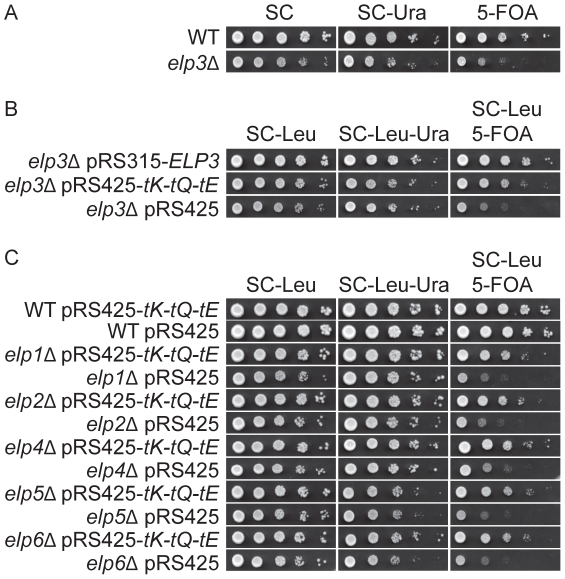
Increased levels of tRNALys
s2
UUU, tRNAGln
s2
UUG, and tRNAGlu
s2
UUC suppress the telomeric silencing defect of Elongator mutants.(A) The wild type (UMY2584) and elp3Δ (UMY3790) strains were 10-fold diluted, spotted on SC, SC-Ura and SC+5-FOA plates, and incubated at 30°C for 2 days. (B) The elp3Δ strain (UMY3790) with plasmids, pRS315-ELP3, pRS425-tK-tQ-tE or pRS425, were 10-fold diluted, spotted on SC-Leu, SC-Leu-Ura and SC-Leu+5-FOA plates, and incubated at 30°C for 2 days. (C) The wild type (UMY2584), elp1Δ (UMY3788), elp2Δ (UMY3789), elp4Δ (UMY3791), elp5Δ (UMY3792) and elp6Δ (UMY3793) with plasmids pRS425-tK-tQ-tE or pRS425 were treated as described in (B). Abbreviations for the tRNA genes encoding ,  and  are tK, tQ and tE, respectively.